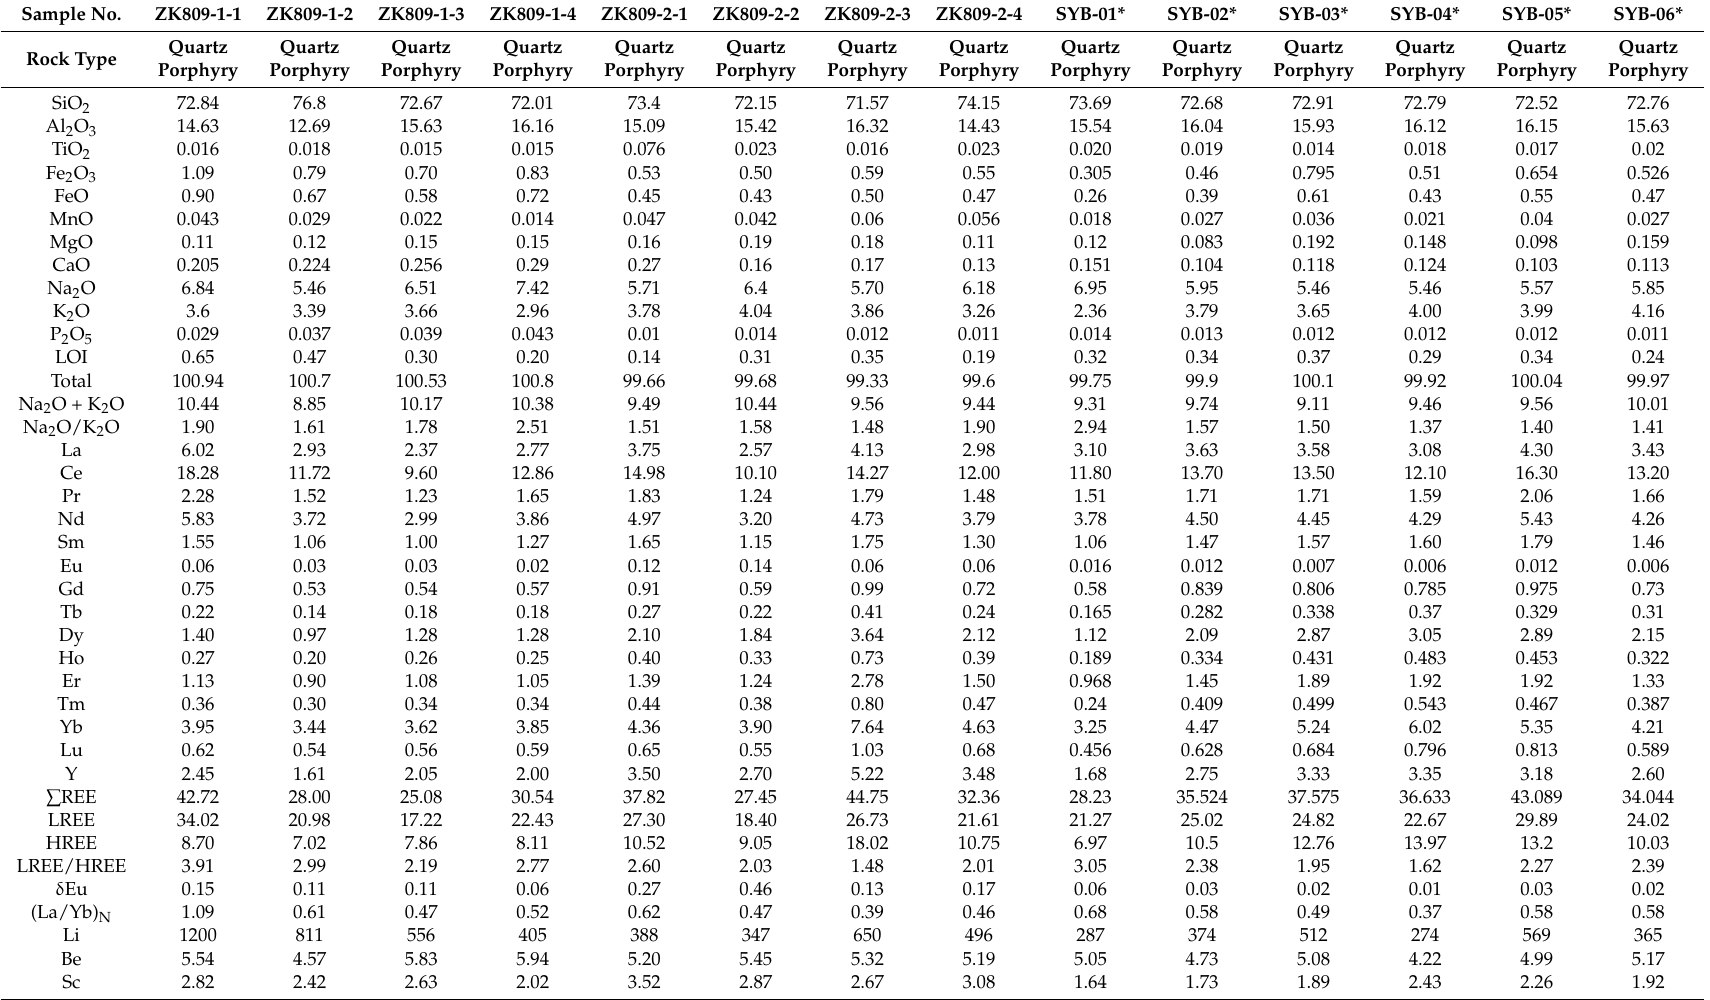
Table 3. Major (wt %) and trace elements (ppm) data of quartz porphyry from the Weilasituo Sn-polymetallic deposit. Sample